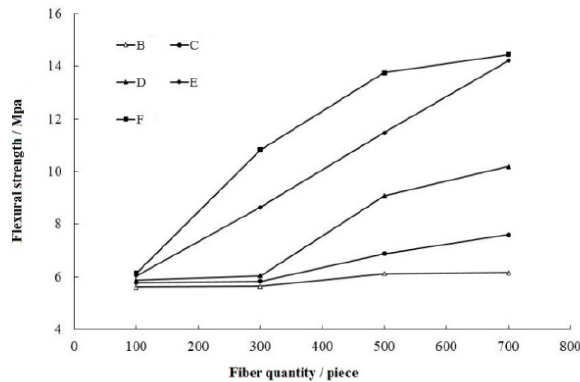
Figure 7. Breaking load of each experimental group.